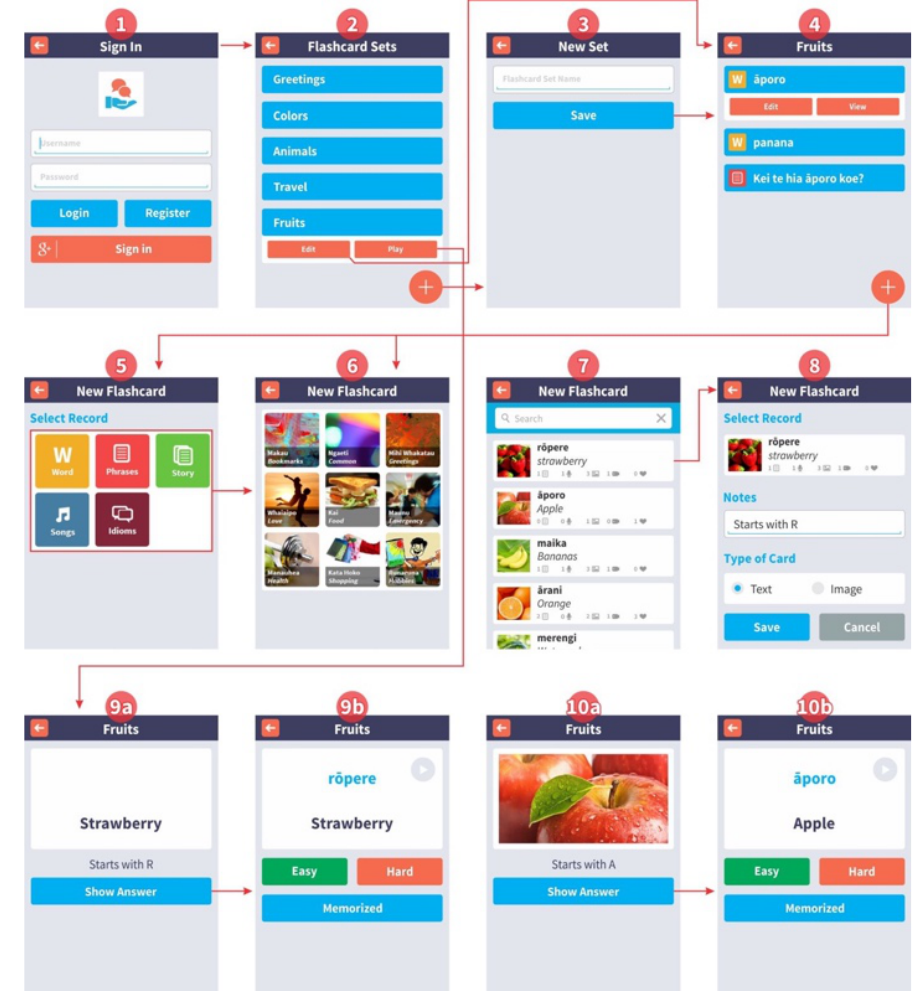
Figure 6. Learn Lingo – Flash cards app workflow